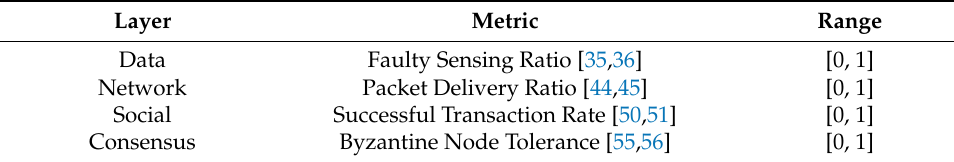
Table 2. Trustworthiness